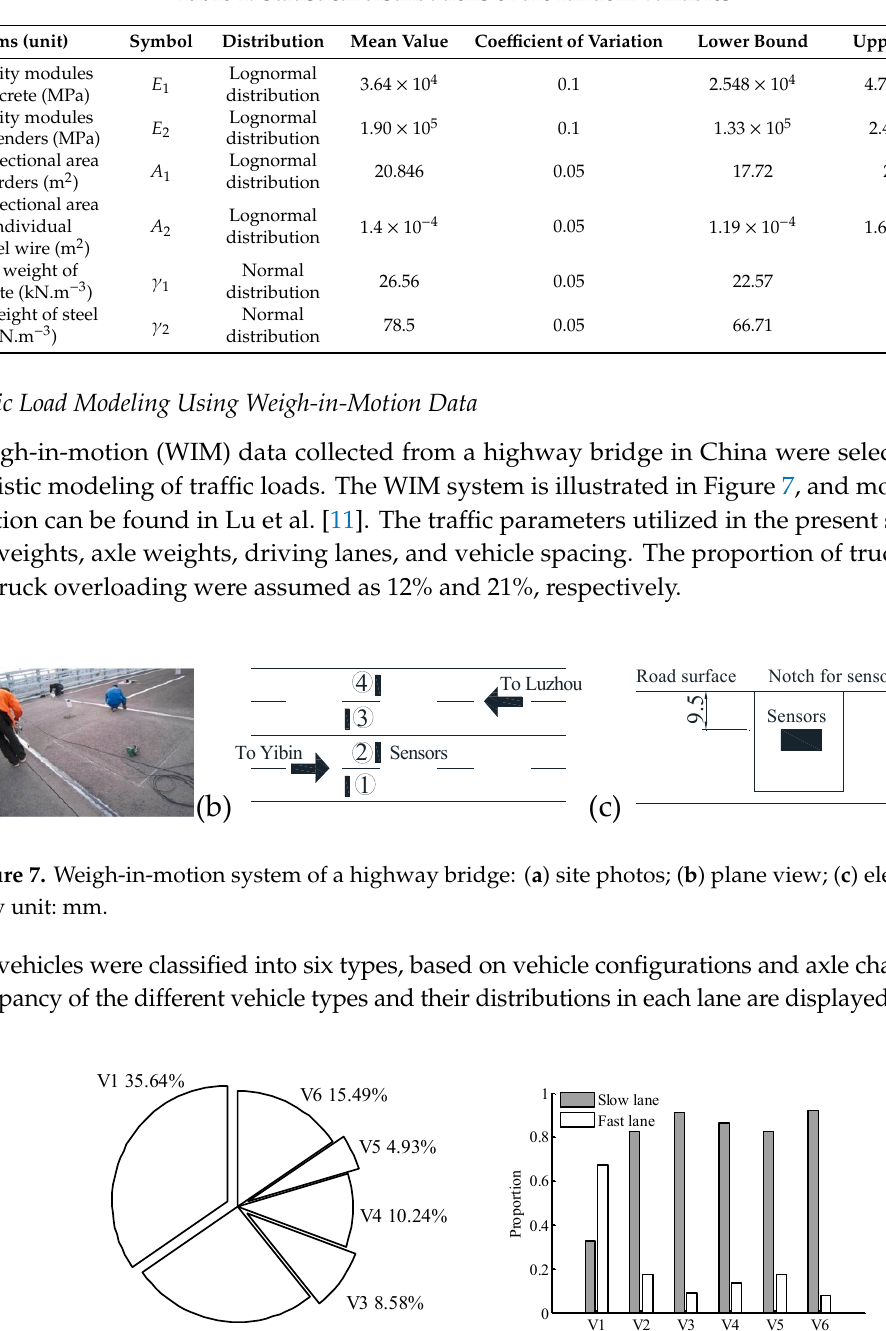
Table 1. Statistical distributions of the random variables.